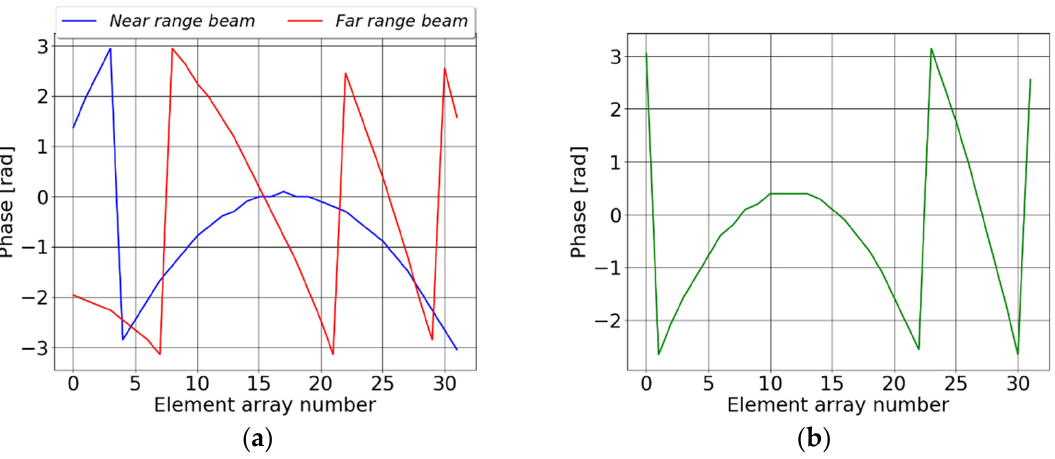
Figure 1. Phase tapers (in radians) of the array elements ( a ) for the near range beam of 120 km ground swath (blue curve) scenario and the far range beam of 120 km ground swath scenario (red curve) and ( b ) for 240 km ground swath scenario.